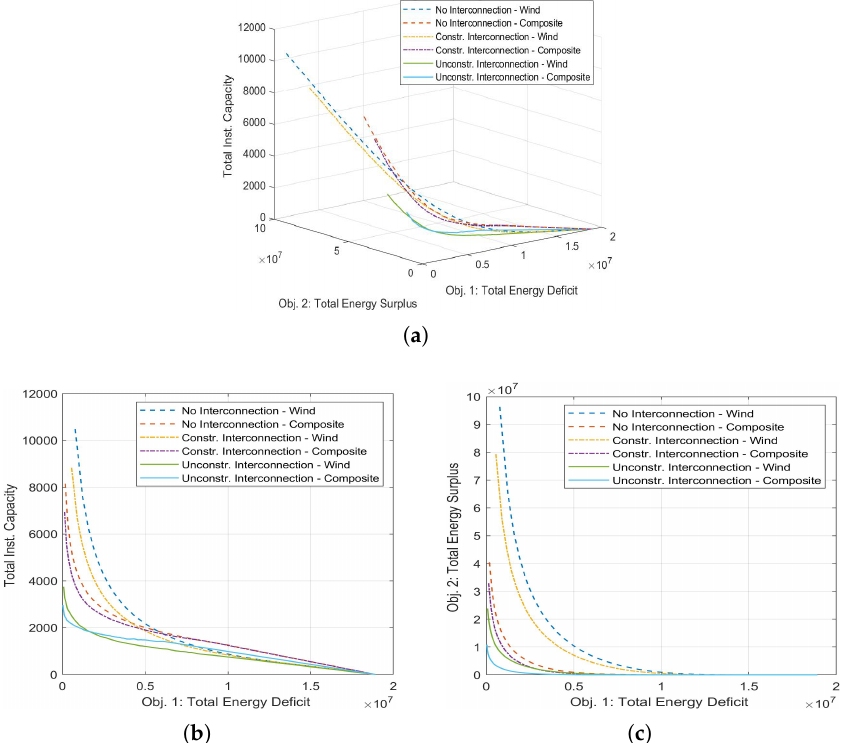
Figure 6. Pareto-optimal fronts: ( a ) in the space of three performance metrics (balancing, curtailed energy and total installed capacity) and ( b , c ) projected onto two dimensional